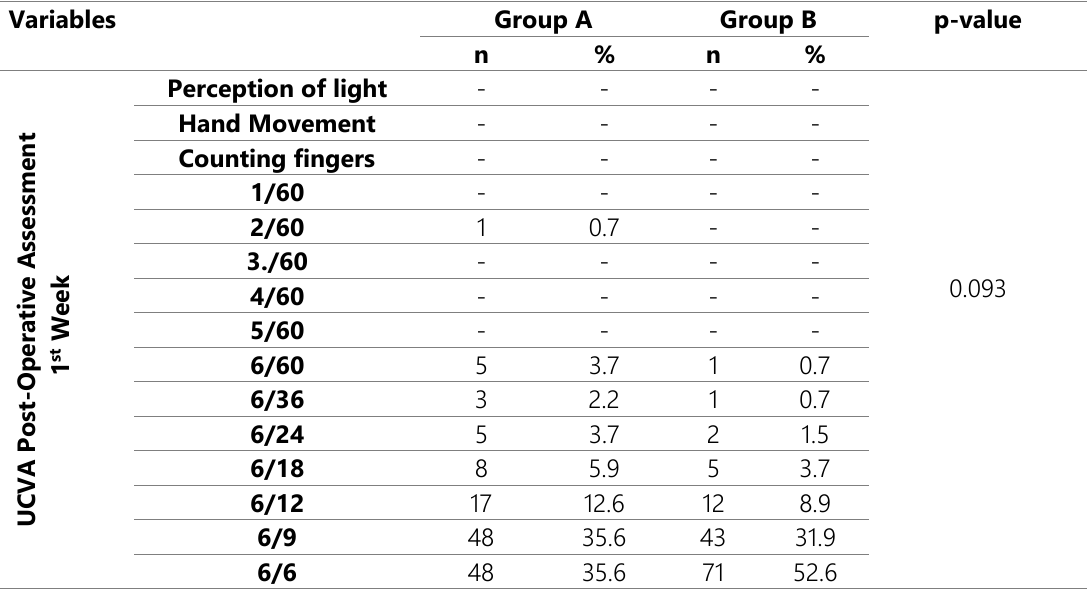
Table 3: Uncorrected visual acuity according to Snellen Eye chart at 1 st week of postoperative follow-up